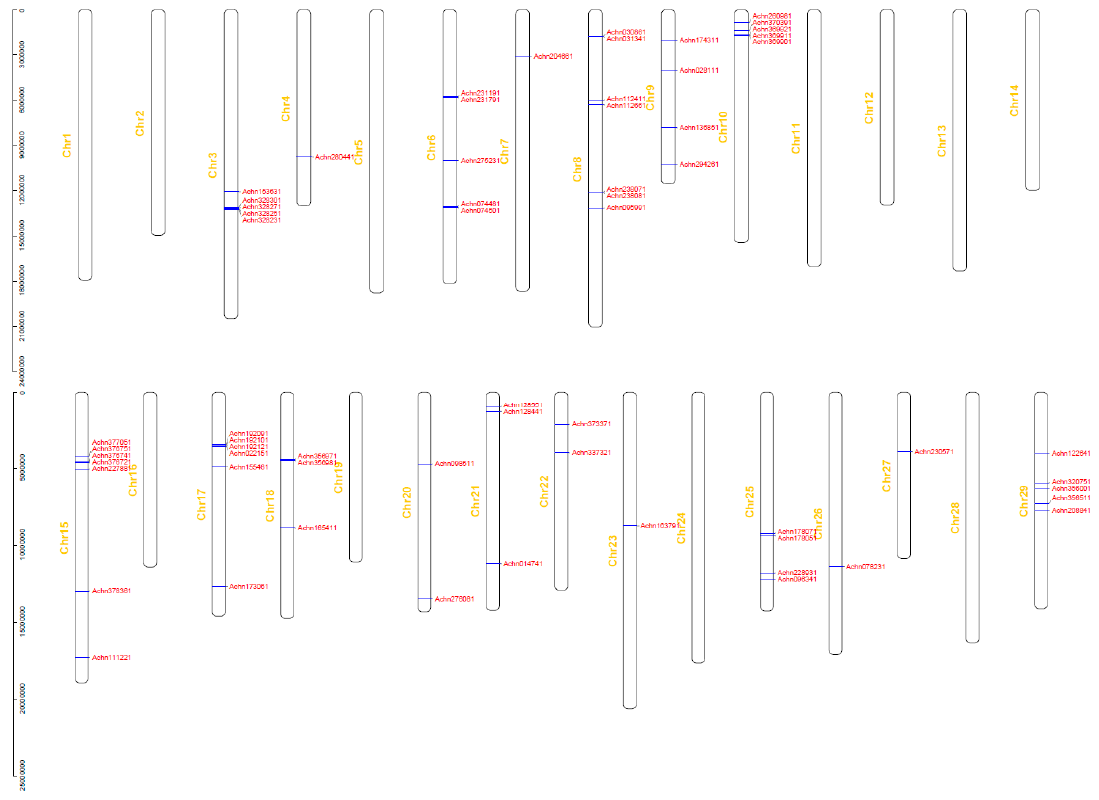
Figure 2. Chromosomal distribution and gene clusters of the NBS-LRR genes of kiwifruit.